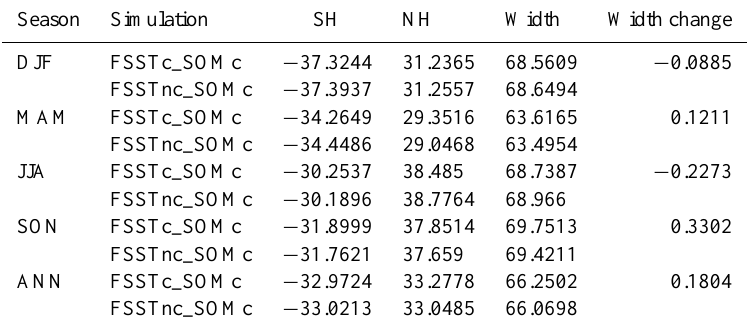
Table 5. Same as Table 4 but for the fixed SST runs.